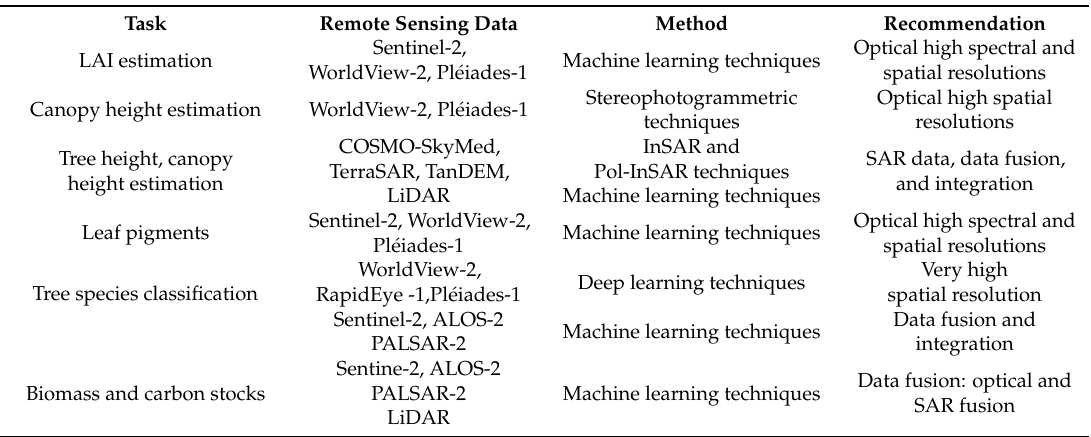
Table 6. Recommendations for monitoring mangrove areas and structures. InSAR: interferometric synthetic aperture radar, Pol-InSAR: polarimetric SAR